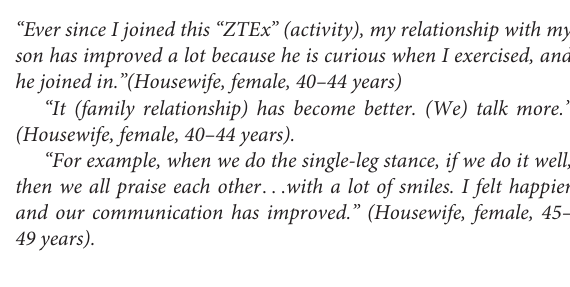
greater improvements in family well-being by 1.08 scores